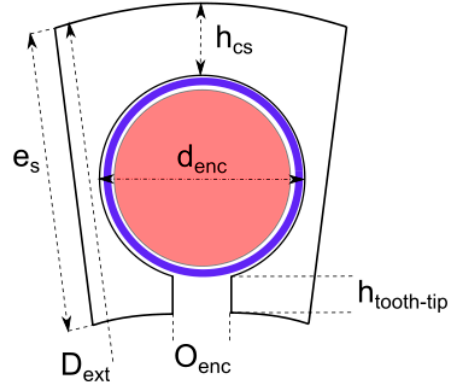
Figure 30. Dimension of the slot.